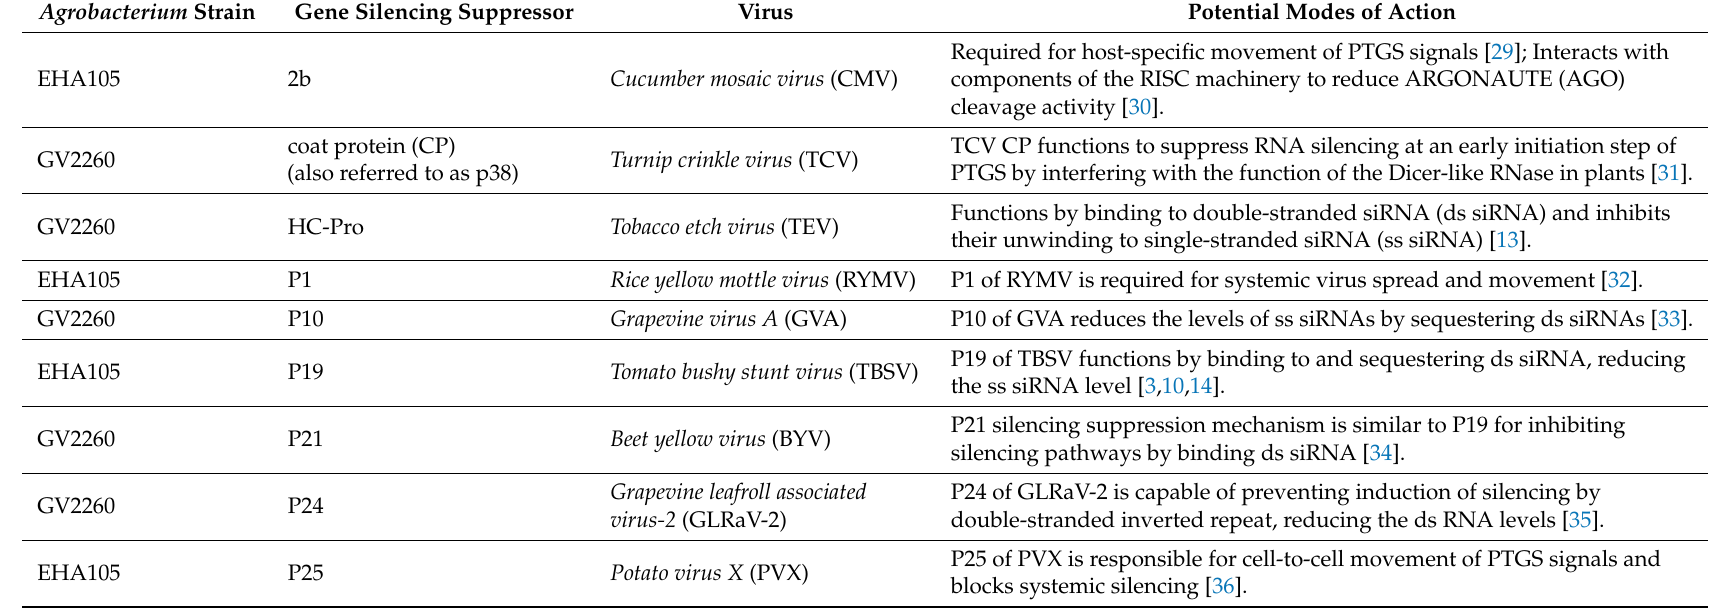
Table 1. Viral gene silencing suppressors of RNA silencing investigated in this work. Agrobacterium Strain Required for host-specific movement of PTGS signals [29]; Interacts with components of the RISC machinery to reduce ARGONAUTE (AGO) cleavage activity [30]. PTGS by interfering with the function of the Dicer-like RNase in plants